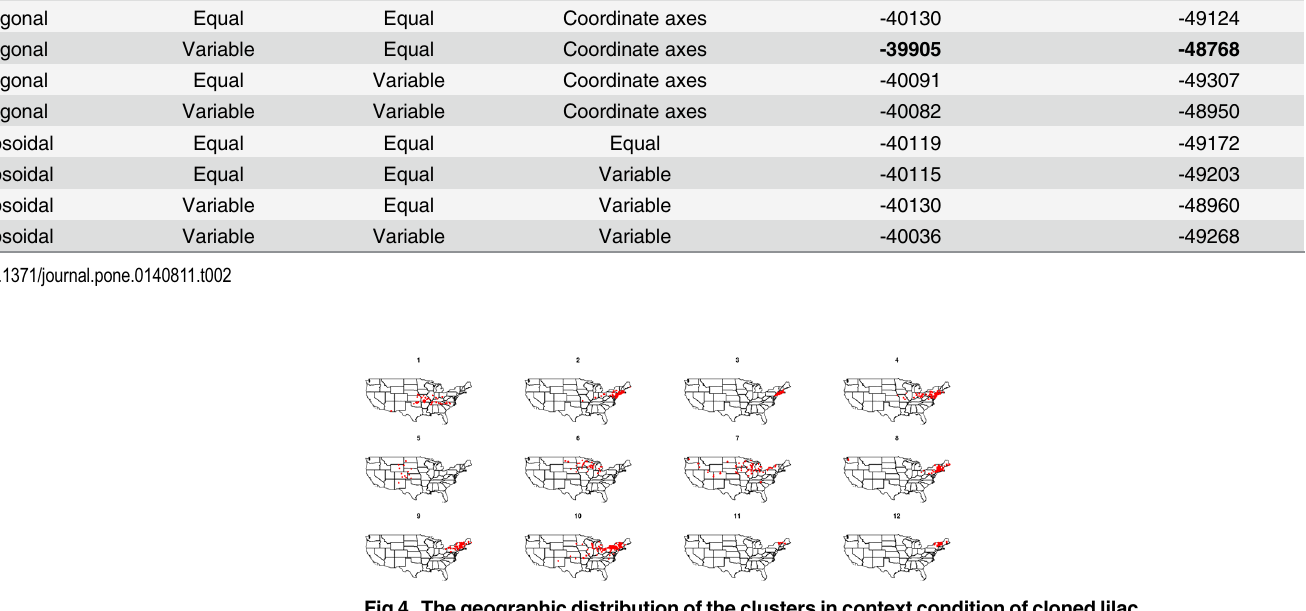
Fig 4. The geographic distribution of the clusters in context condition of cloned lilac.